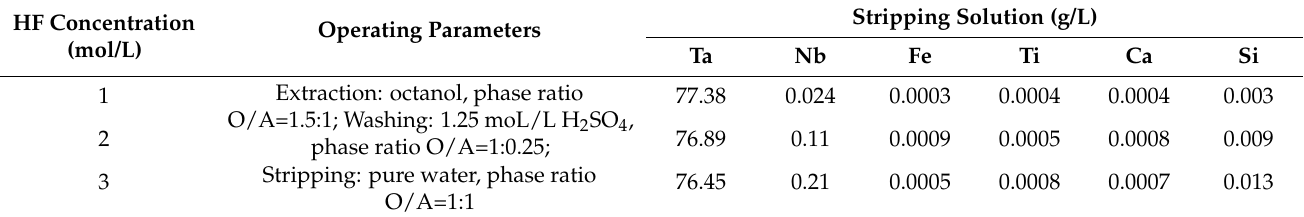
Table 4. Ta extraction from the low-acid leaching solution.